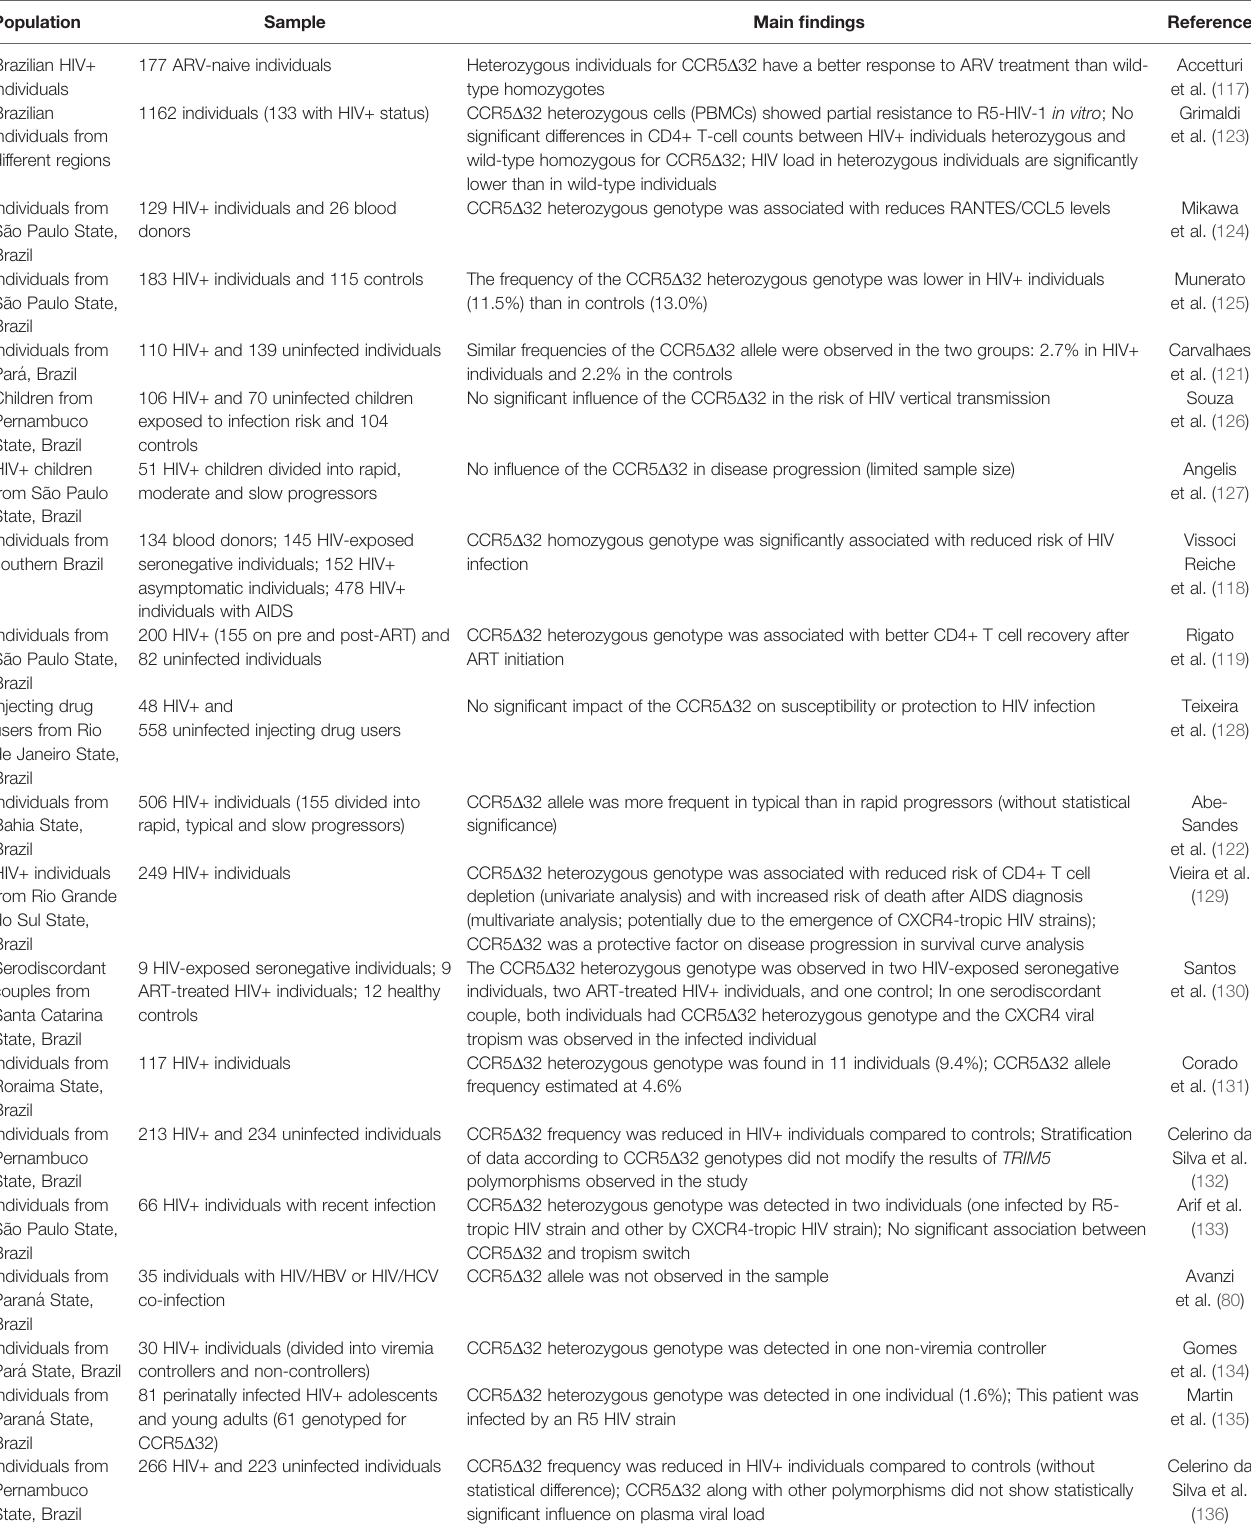
TABLE 1 | Impacts of the CCR5 D 32 on HIV infection.